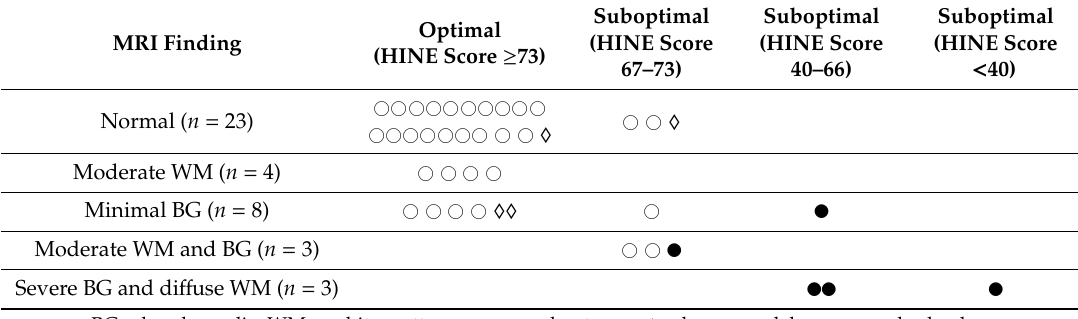
Table 3. Optimality scores and MRI findings: Correlation with outcome at 2